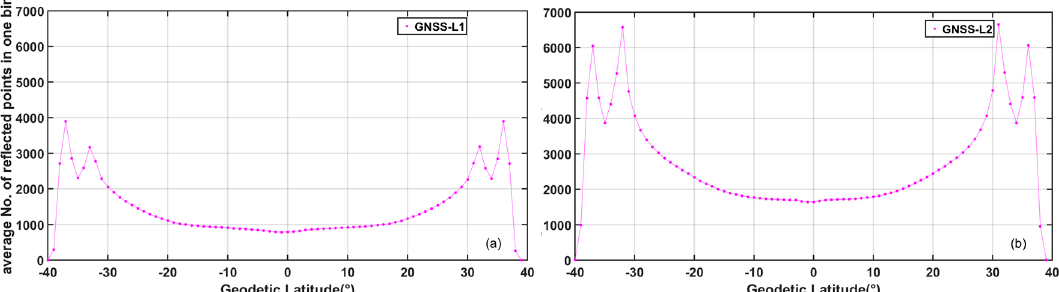
Figure 10. Average numbers of four-system GNSS-R specular reflection points in 1° × 1° grids at different longitudes during a complete 13-day cycle at the GPS L1 ( a ) and L2 ( b ) frequencies.